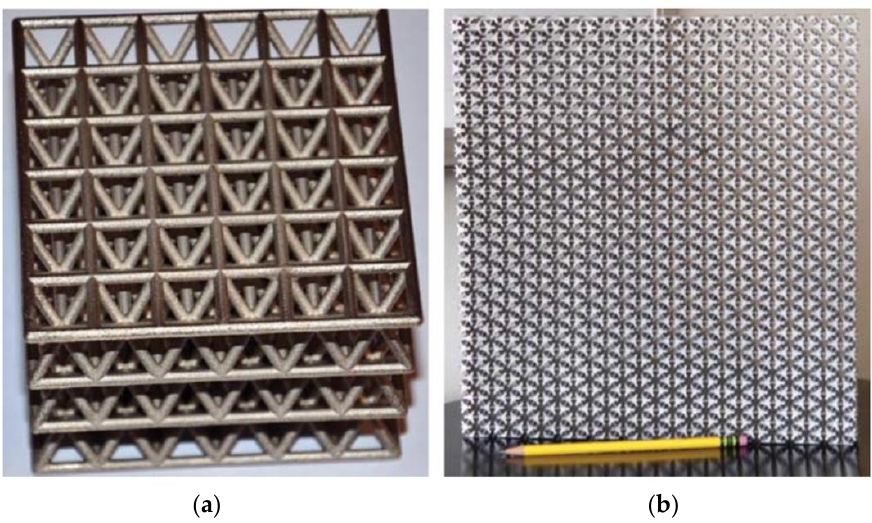
Figure 2 . Lattice materials formed by network of beams; ( a ) ultralight Nano-metal truss hybrid lat- tice; ( b ) penta-mode lattice [12] .